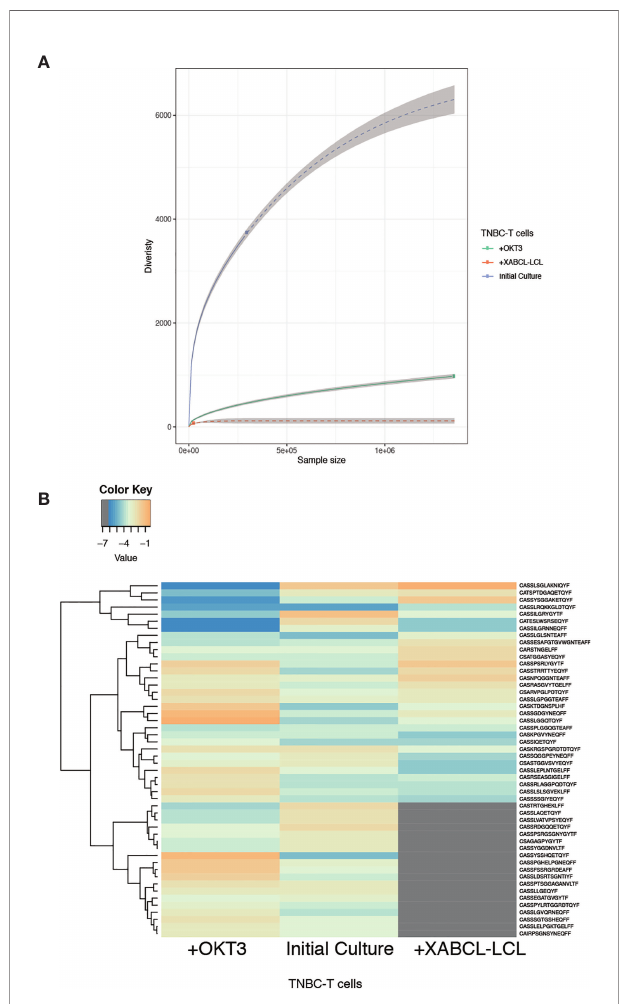
FIGURE 4 | TNBC-T cells expanded in vitro in the presence of XABCL-LCL presented a highly restricted TCR repertoire with a different pattern. (A) The TCR repertoire size and diversity hugely decreased in the TNBC-T cell sample expanded in the presence of irradiated XABCL-LCL (60 Gy), compared with TNBC-T cells expanded with OKT3 (anti-human CD3). (B) The heat plot using the 50 most abundant clonotypes revealed that the TCR repertoire pattern of expanded TBNC-T cells was also different in the T cells grown with XABCL- LCL, instead of with OKT3, as several sequences were not found in common and different frequencies of the shared clonotypes were observed ( Supplementary Table 3